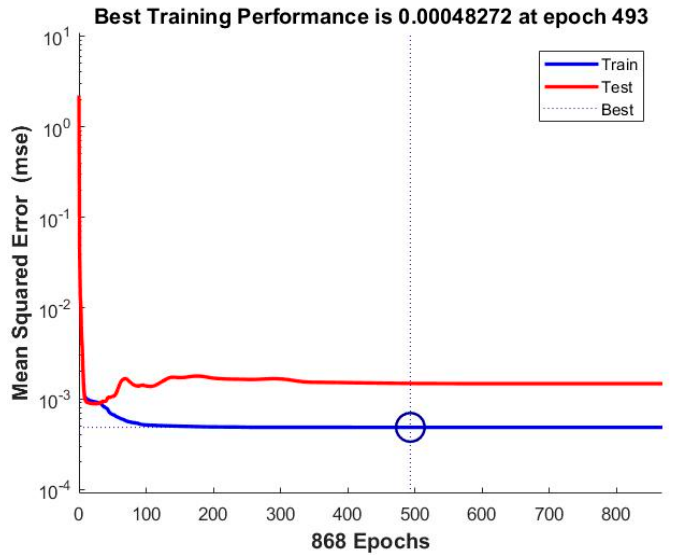
Figure 5. The best training performance when forecasting the electricity consumption for the month of December, using the ANN_NAR_BR network.